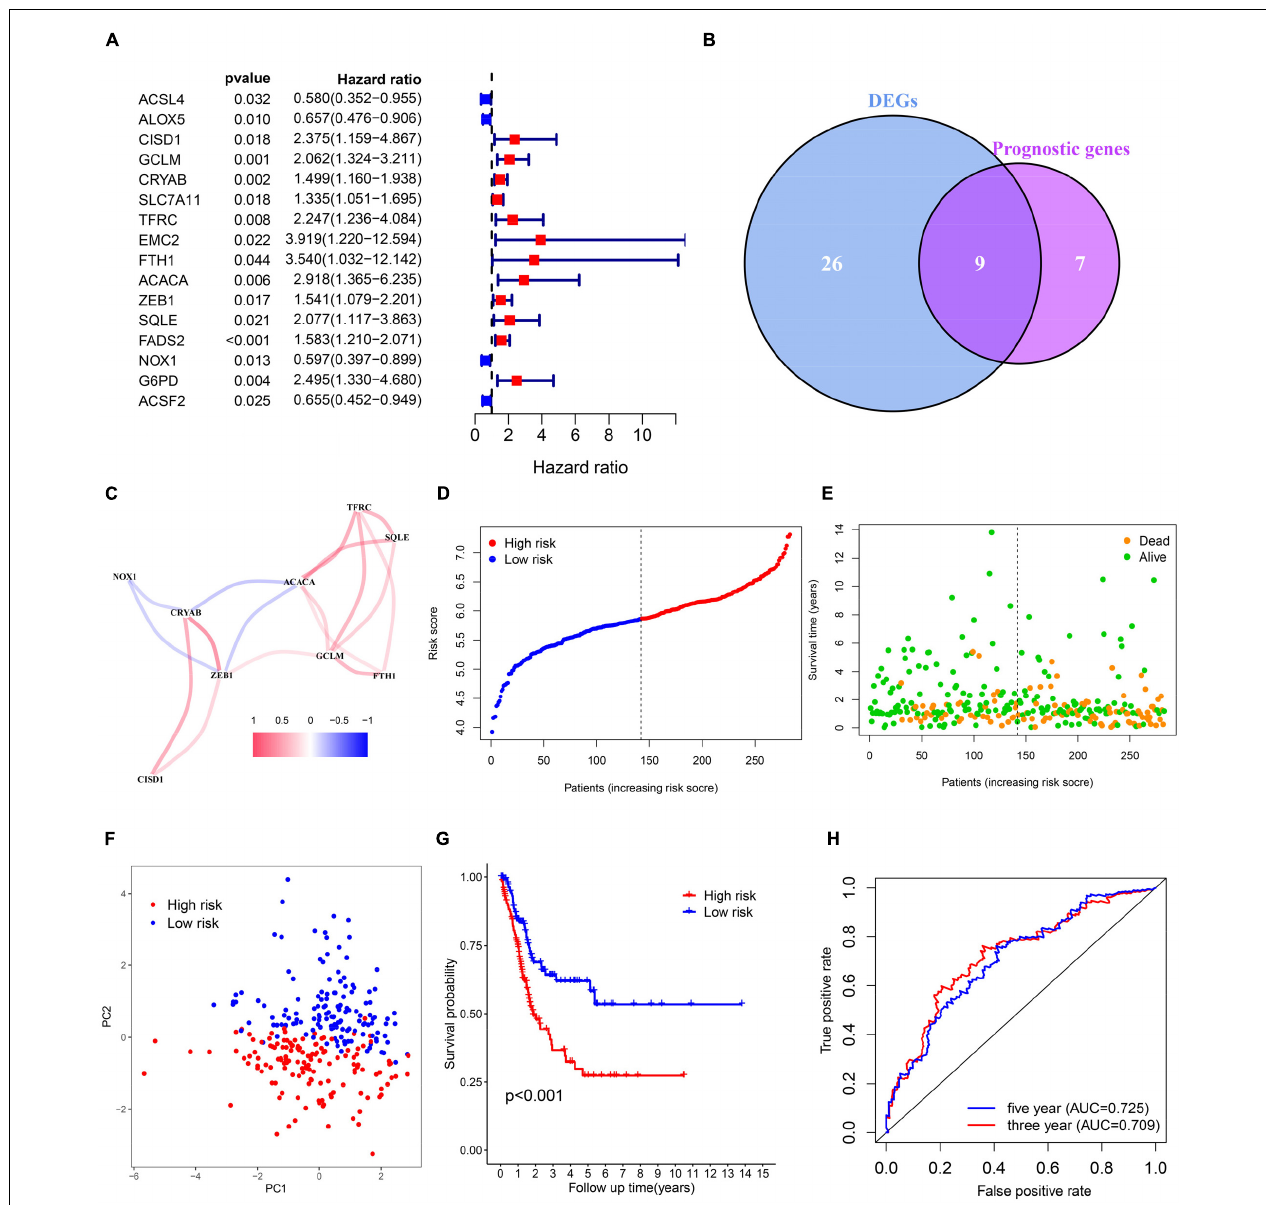
FIGURE 2 | Identification of bladder cancer-specific ferroptosis-related genes and construction of the prognostic model. (A) Forest plots based on univariate survival analysis in patients with BC. (B) Venn diagram for overlapping genes among differentially expressed genes (DEG) correlated with patient outcome. (C) The correlation network of candidate genes. (D–F) Risk score distribution, overall survival (OS) status and PCA plot of high and low risk BC cases in the TCGA data. (G) Kaplan-Meier survival curves of patients in BC groups of different risk score in the TCGA cohort. (H) Time-dependent ROC curves of overall survival at 3- (red) and 5-years